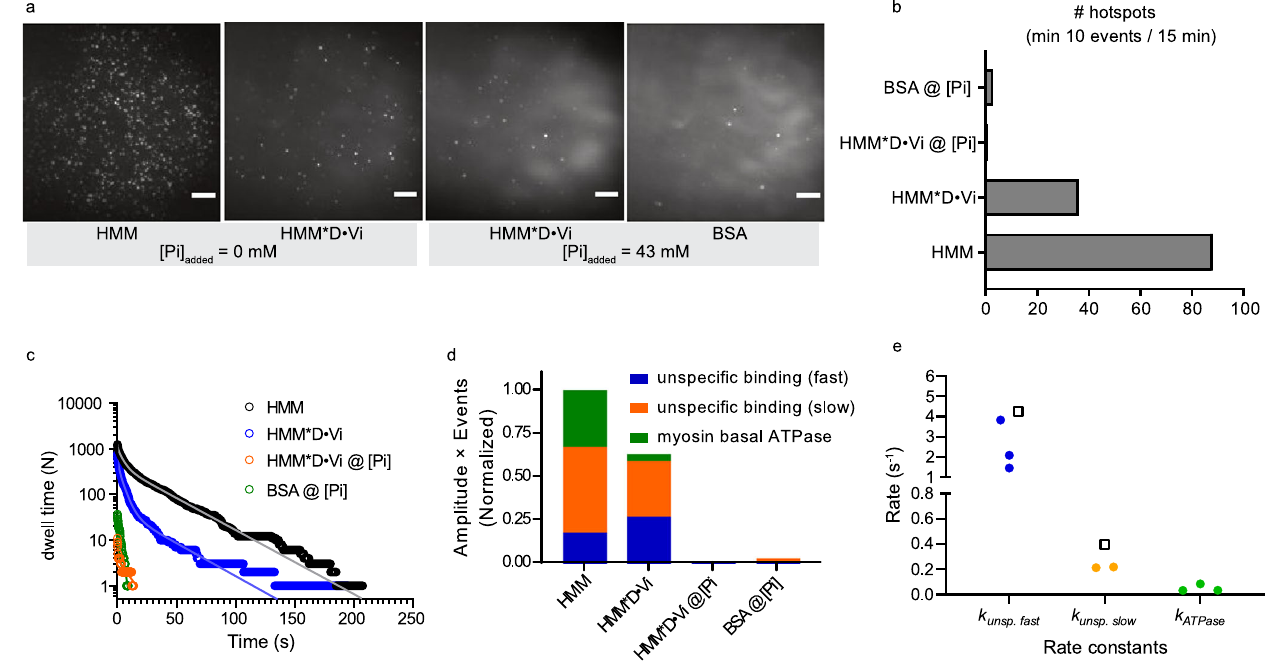
Fig. 3 | Pi-mediated competitive inhibition of Alexa647-ATP binding to HMM with non fl uorescent ADP (D) locked to the active site by the presence of vanadate (V i ). a Time-averaged Alexa647-ATP binding re fl ected in fl uorescence projections (Zprojection standard deviation in ImageJ) of 15min videos (50ms exposure time/frame) under 0 and 43mM added [Pi] after preincubation with HMM (34.3 pM) with or without pretreatment with ATP and vanadate (HMM:ATP:vanadate;1:117:583molarratios).Incontrolexperiments,thecoverslips were coated only with bovine serum albumin (BSA). Note a decrease in the total number of Alexa647-ATP binding spots per image with added Pi. The observed decreaseinspotnumberbetweenHMMandHMM*D·Vi(at0mMaddedPi)should be treated with caution since some of the heads could be lost during HMM*D·Vi complexespreparationfordifferentreasons 35 .Scalebars,5 µ m. b Hotspotsnumber estimation under different experimental conditions. c Cumulative frequency